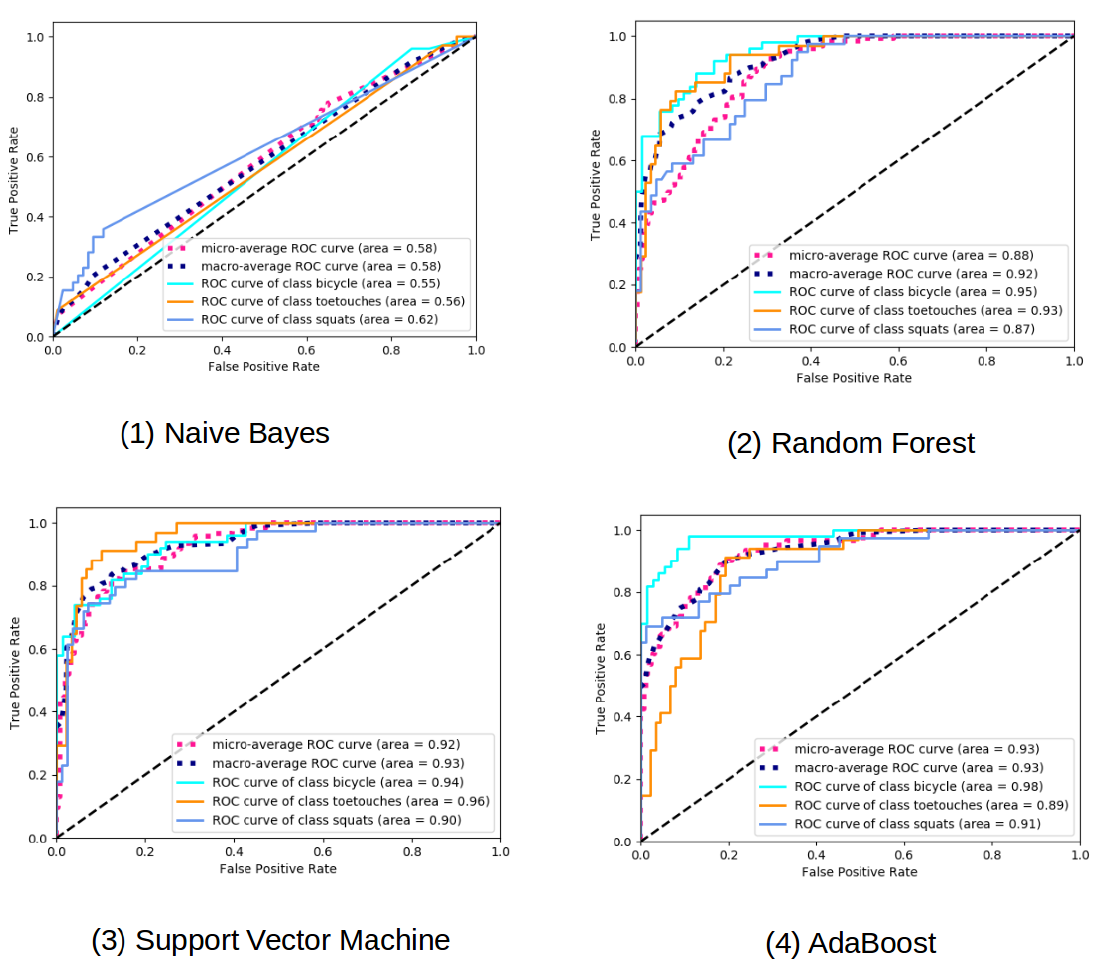
Figure 4. The ROC curve for different classifiers are depicted. Top left ( 1 ) shows the ROC curve for Naive Bayes Classifier. Top right ( 2 ) shows the ROC curve for the Random Forest classifier. Bottom left ( 3 ) shows the ROC curve for the Support Vector Machine classifier. Bottom right ( 4 ) shows the ROC curve for the Adaboost classifier. As can be extracted from the results, the Naive Bayes classifier performs the worst, which is only slightly better than random guessing. The Support Vector machine performs the best compared to the other classifiers. For all three classes, the ROC curves behaves similarly and shows the most robust